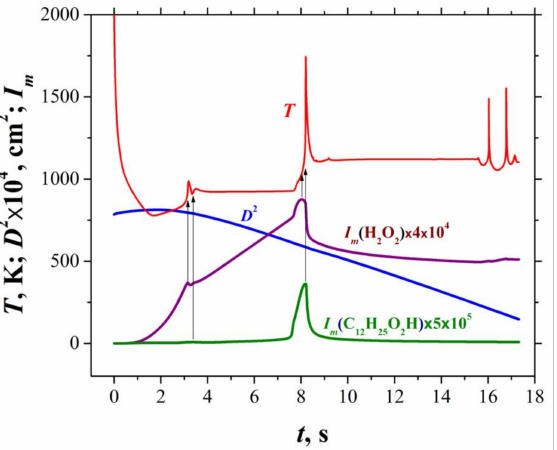
Figure 14. Calculated time histories of the integral mass fractions I m (C 12 H 25 O 2 H) and I m (H 2 O 2 ) as well as the maximum gas temperature, T m , and the squared droplet diameter, D 2 , at the forced ignition and combustion of the n-dodecane droplet with D 0 = 2.8 mm and L = 0.53 cm in air at NPT conditions. Arrows mark the instants of C 12 H 25 O 2 H and H 2 O 2